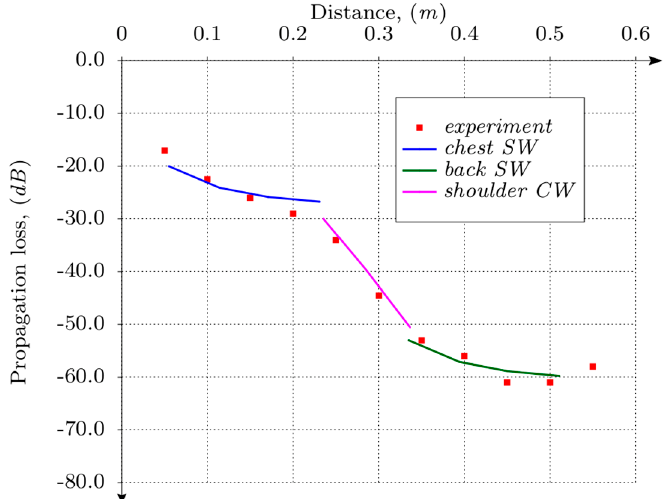
Figure 21. Measured insertion loss between the antennas along the path on a body. The distance between the antennas is shown on the horizontal axis, and the insertion propagation loss is shown on the vertical axis. Red dots represent the measured receiving antenna positions. The blue and green line is the predicted SW propagation loss from the modeling results presented in Figure 15a, and the magenta line is the predicted CW propagation loss from the modeling results presented in Figure 15b.